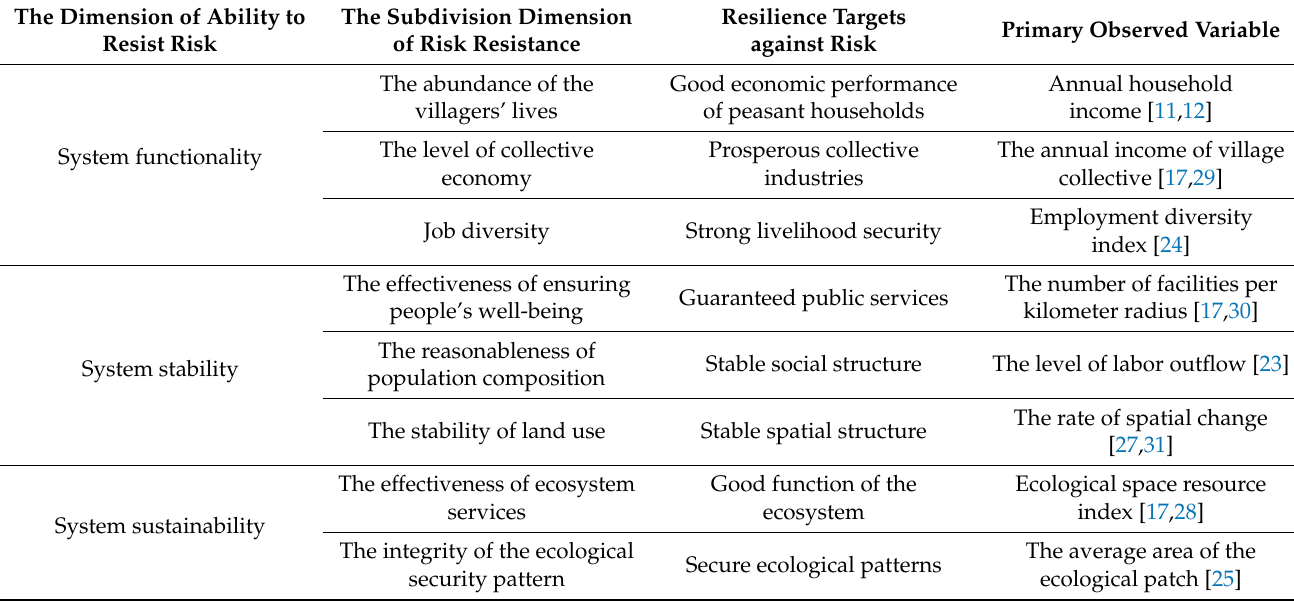
Table 3. Observational variables characterizing rural risk